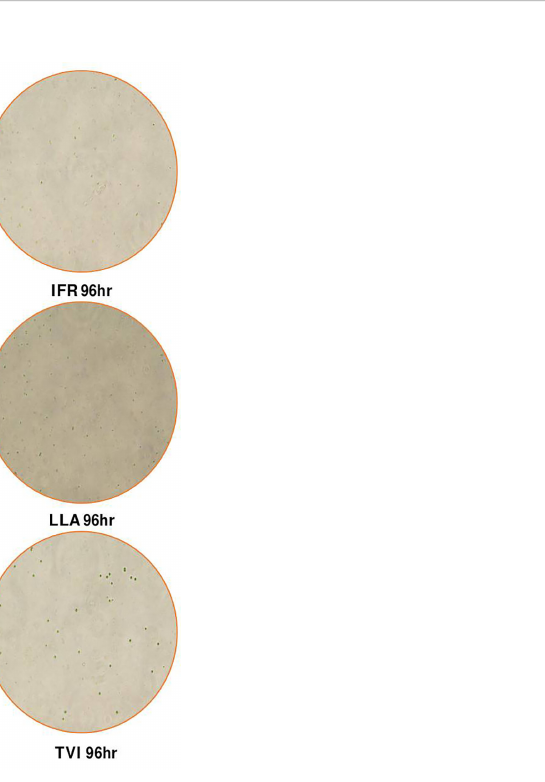
FIGURE 7 The structures of the fungal biocontrol agents, Isaria fumosorosea (IFR) , Lecanicillium attenuatum (LLA), and Trichoderma virens (TVI) under an electron microscope, 96 hrs after inoculation in the aquaponics